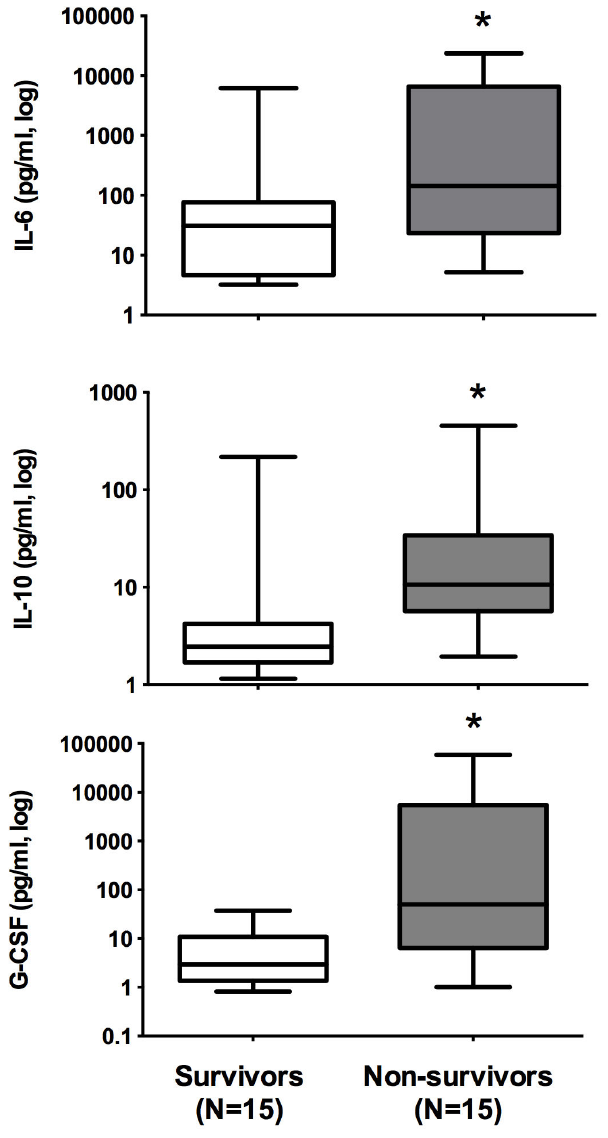
first day of sepsis diagnosis: comparison of the IL-6, IL-10, and G-CSF plasma levels on the first day of sepsis. (*) p <0.05. doi: